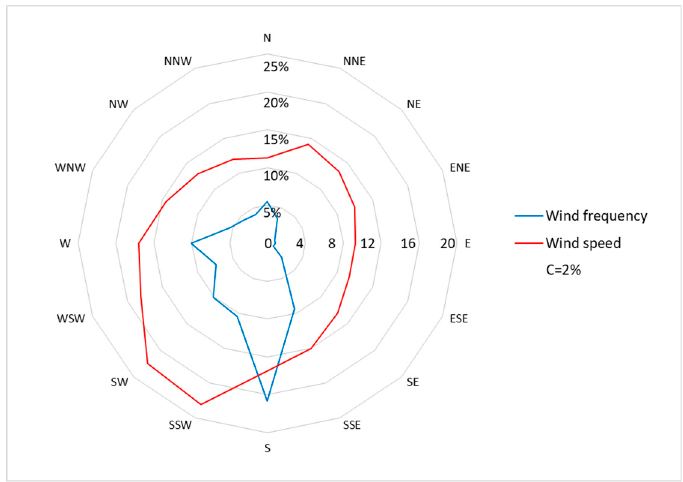
Figure 7. Wind speed (km/h) and direction frequency (%) chart of ozone excess days in Changchun in 2015.